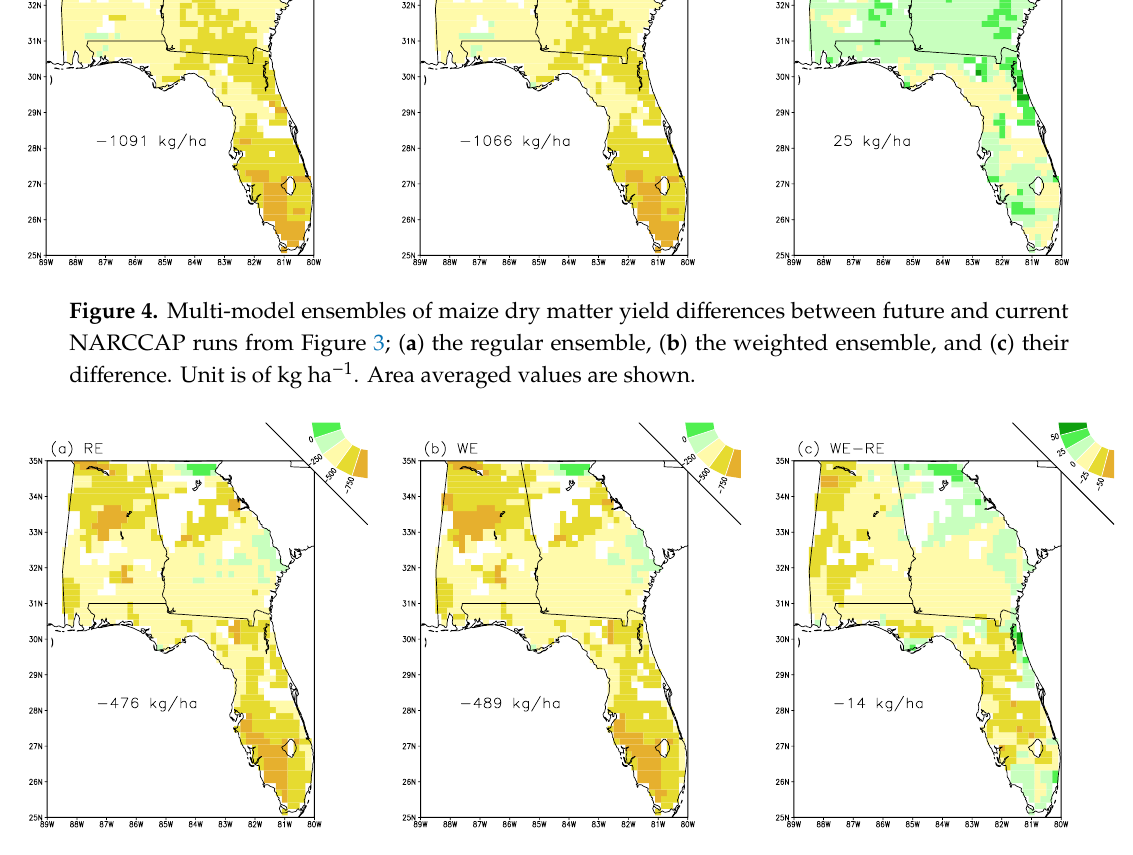
Atmosphere 2020 , 11 , x FOR PEER REVIEW Figure 5. As in Figure 4, but for peanut. Figure 5. As in Figure 4, but for peanut. Figure 5. As in Figure 4, but for peanut.